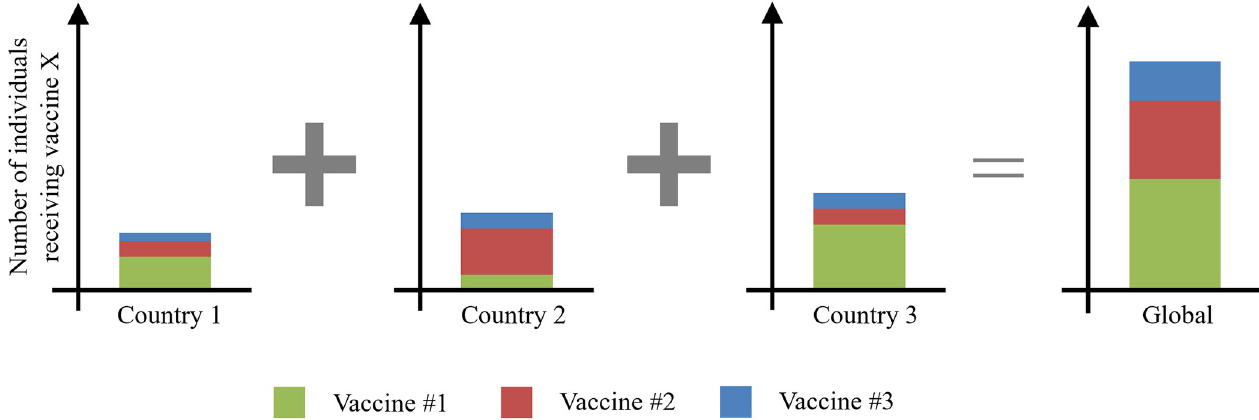
Fig 4. Conceptual diagram of the aggregation of several country-level portfolios into a single global-level portfolio, for a given vaccine ordering scenario (in this case Vaccine #1 ! Vaccine #2 ! Vaccine #3). Individual country demand for each vaccine presentation is calculated using the country-specific portfolio distribution and total eligible population. Country-level demands are then summed to yield the global demand for each vaccine presentation.